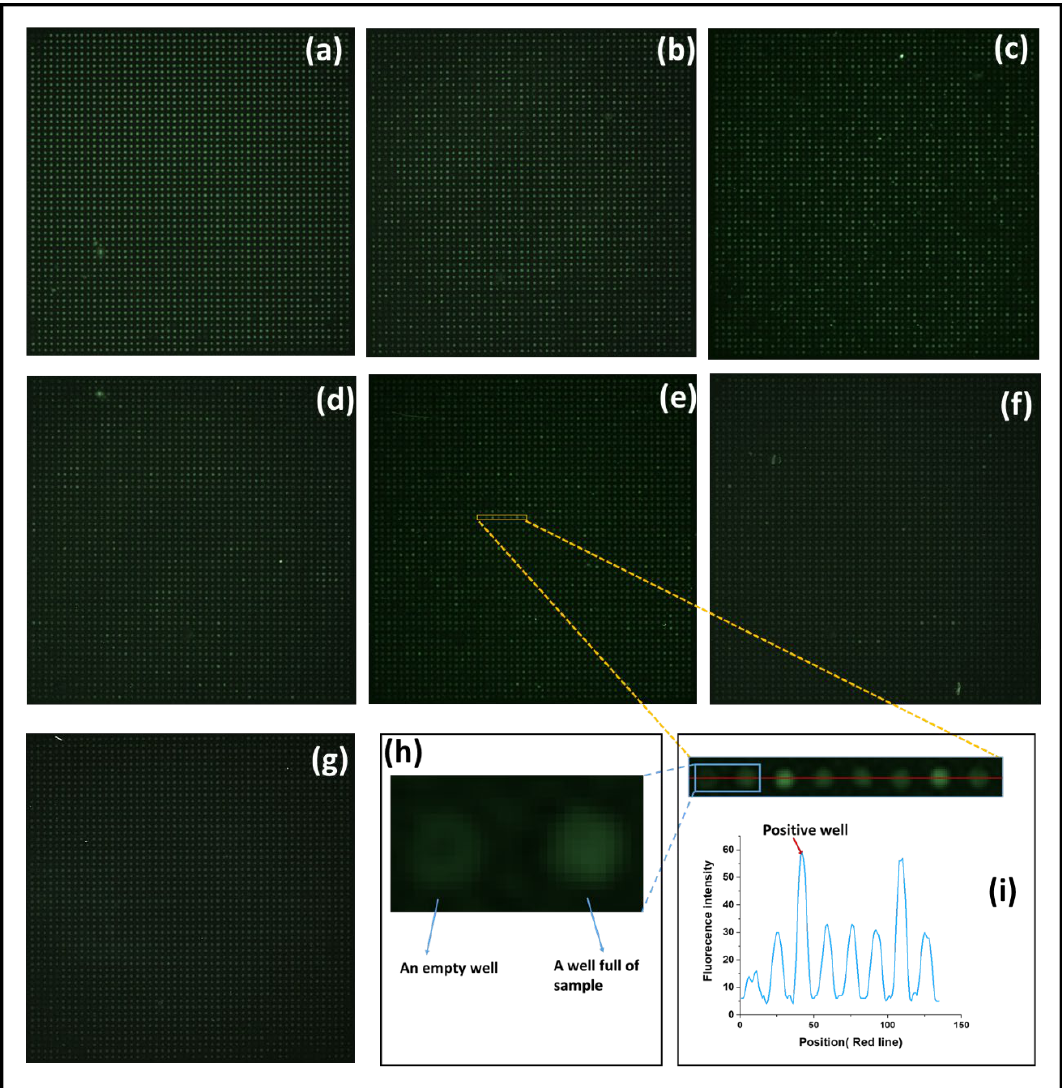
Figure 7. Fluorescence images of the detection results of the digital PCR chip to detect different concentrations of HBV plasmids. The HBV plasmid dilution concentrations were ( a ) 10 − 1 ; ( b ) 10 − 2 ; ( c ) 5 × 10 − 3 ; ( d ) 10 − 3 ; ( e ) 5 × 10 − 4 ; ( f ) 10 − 4 ; ( g ) no template control (NTC). ( h ) The image of an empty well and a well full of the sample. ( i ) A region of interest with eight chambers and the fluorescence intensity distribution in the red line